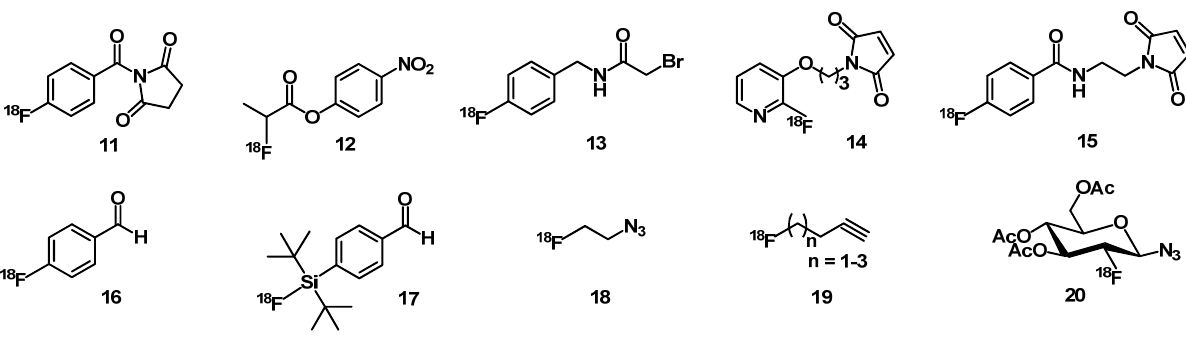
Figure 4. Chemical structure of prosthetic groups for the fluorination of